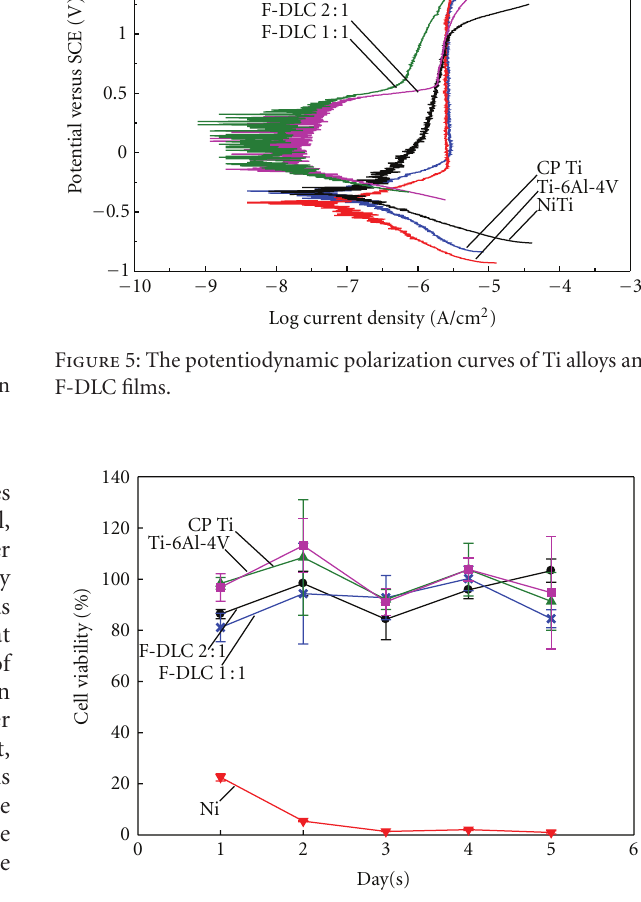
Figure 6: The cell viability of Ti alloys and F-DLC films based on Ni, using DMEM dilution